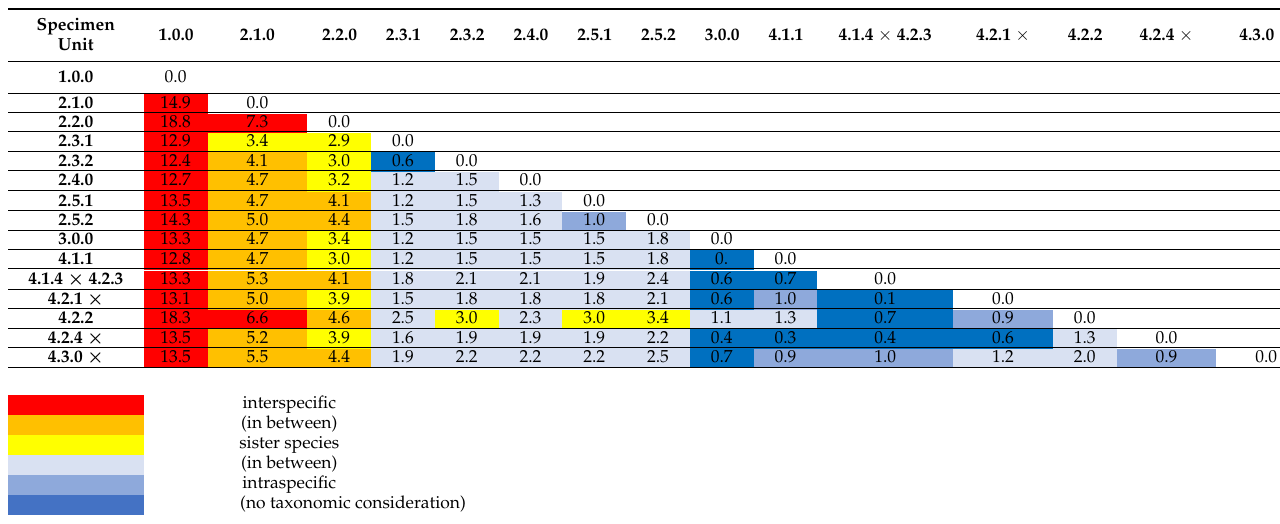
Table 2. Overview of genetic distances. Measured minimal values for genetic distances (GD min as %) between specimen units. No intercluster hybrids are included. For unit 3.0.0, only nonhybrid samples were included. A mean value of average genetic distances between sister species was assessed by the method of Qin et al. [69] and estimated at 3.98% (95% confidence interval 3.36–4.59%). GD min values are expected by us to be ca. 20% lower than the